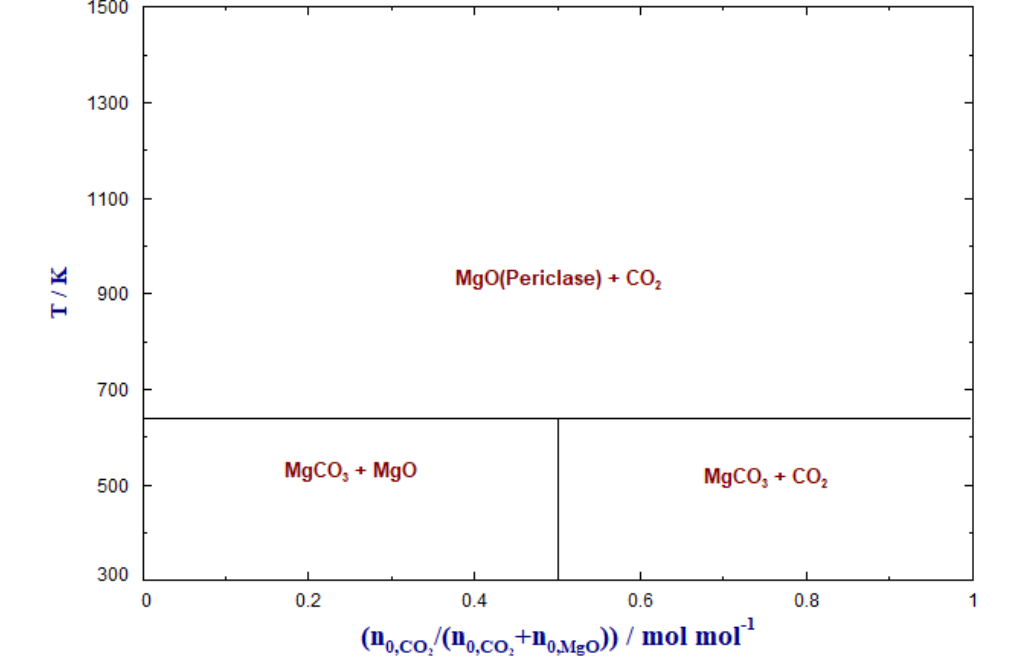
Figure 2. Equilibrium solid phase diagram of the system MgO–CO 2 : solid phase fields were predicted as a function of the temperature and the feed hydrogen mole fraction; gaseous products are not shown; data calculated with FactSage 8.0™ (Thermfact and GTT-Technologies).